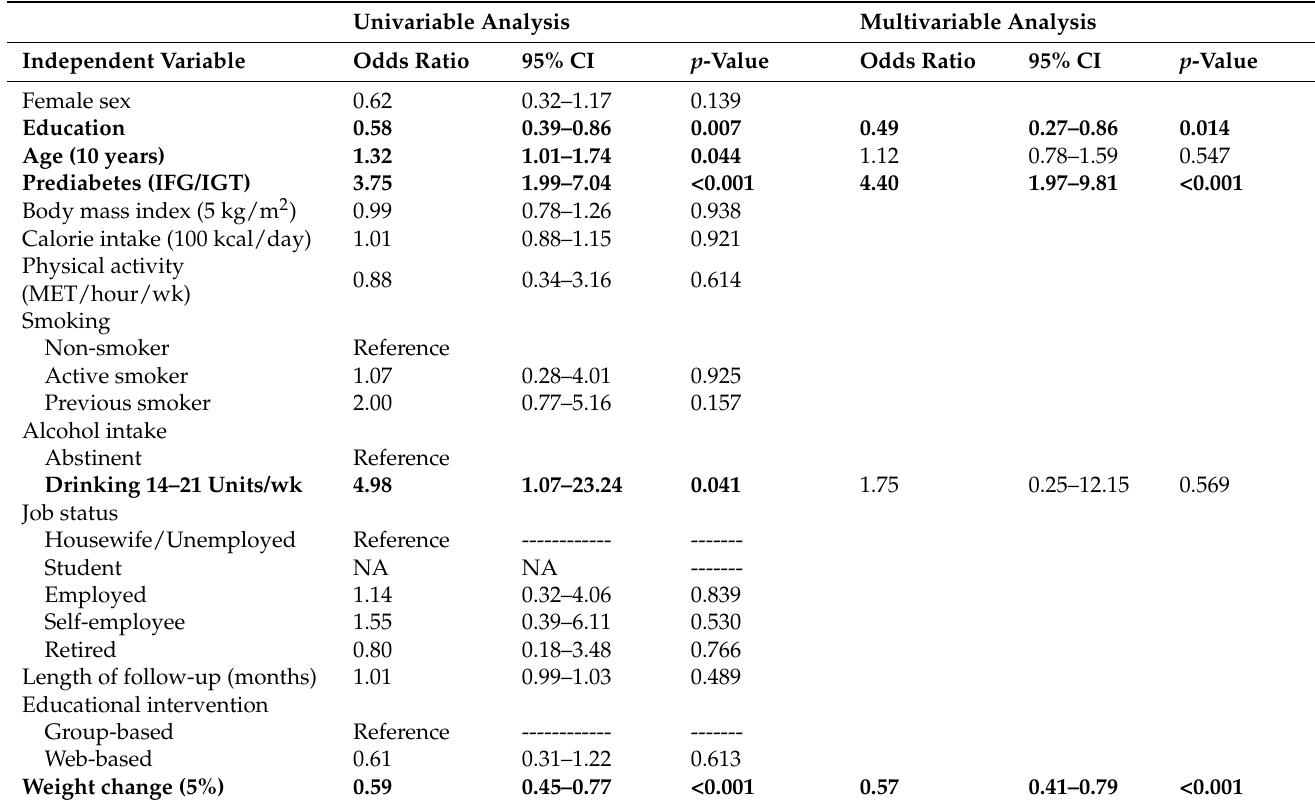
Figure 3. Cumulative incidence of newly-diagnosed diabetes (Kaplan-Meier analysis) in the two groups of patients enrolled into the group-based (GBI) and the web-based (WBI) intervention program. Legend: The number of events and of cases at risk (corrected for attrition) is reported in the bottom table. Note that no differences were demonstrated between groups (Wald test, p = 0.108), after correction for confounders. Table 2. Logistic regression analysis of entry factors associated with newly-diagnosed diabetes in the NAFLD cohort without diabetes at